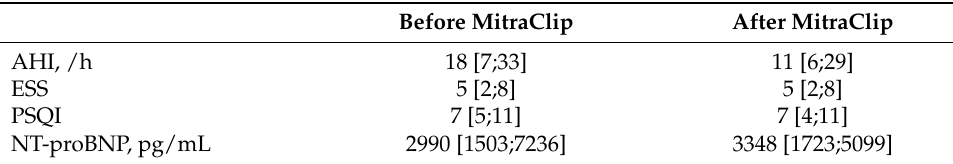
Table 5. Comparison of outcomes before and after MitraClip in 34 patients with follow-up data. Before MitraClip After MitraClip AHI, /h 18